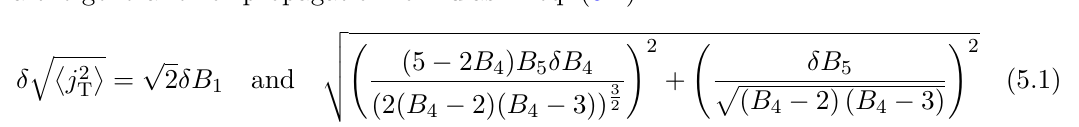
Figure 4. The j T distribution of charged particles with a two-component fit for 60 < p T , jet < 80 GeV / c . The distribution is fitted with the two-component fit described in section 3. by the two-component model fit. The corresponding statistical uncertainties are calculated via the general error propagation formulas in eq.